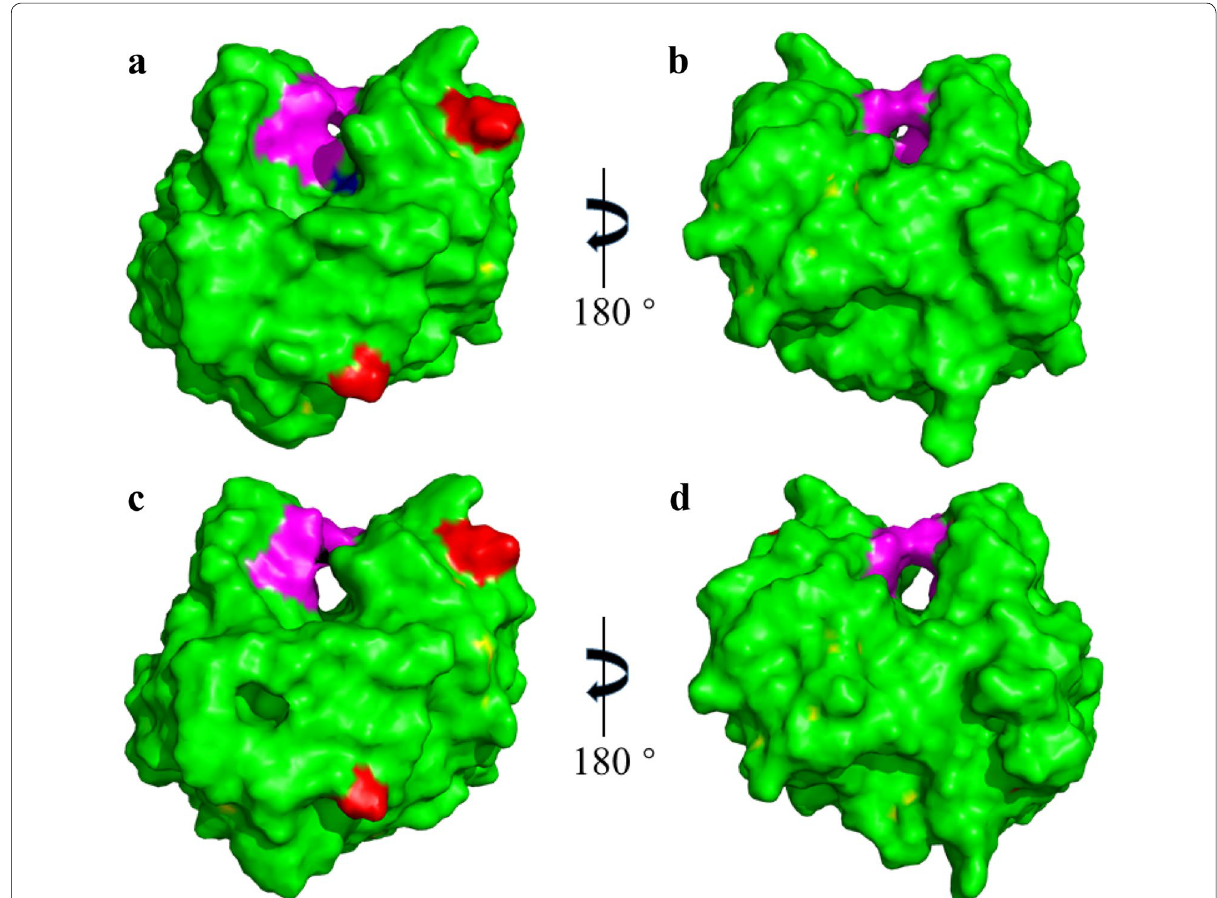
Fig. 5 Surface presentations of the 3D structure of XynHBN188A ( a , b ) and XynHBN188A217 ( c , d ). The mutated amino acid residues are shown in red and the catalytic channel is shown in